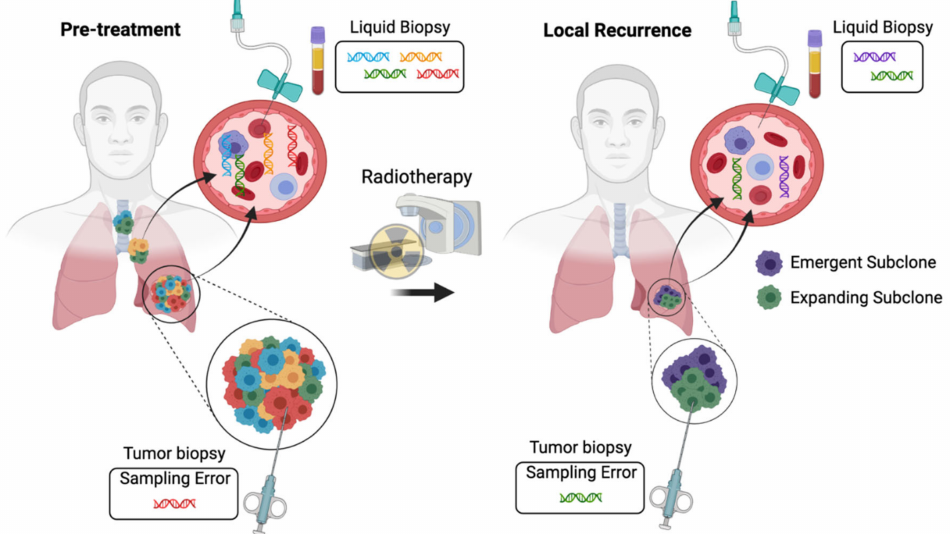
Figure 2. Interrogating tumor heterogeneity, clonal evolution, and resistance to radiotherapy using liquid biopsies. Tumors consist of multiple subclones with distinct genetic alterations. Tumor biopsies sample a single region of one tumor deposit. As a result, resistant subclones may be missed due to sampling error. In contrast, liquid biopsies may characterize the full extent of intratumoral heterogeneity by sampling circulating tumor DNA released from all of the tumor deposits within a patient. Liquid biopsies can also be repeated at multiple time points, enabling the longitudinal tracking of clonal evolution during radiotherapy and the identification of emergent and expanding tumor subclones that mediate radiation